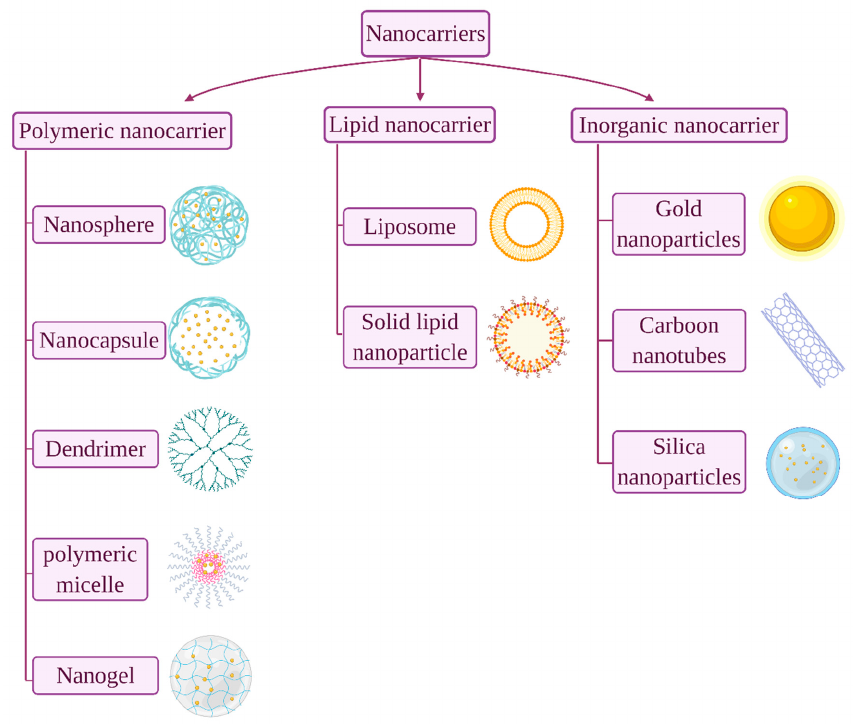
Figure 1. Common nanocarriers used for oral protein/peptide delivery.